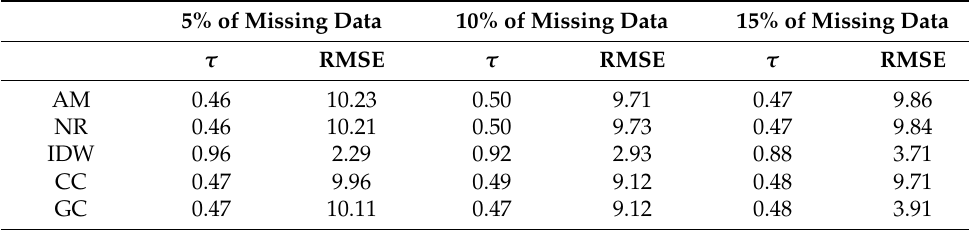
Table 2. Performance of gap-filling methods for station 1 (for location see Figure 1), which has few data gaps, using the Kendall coefficient of correlation ( τ ) and root mean square error